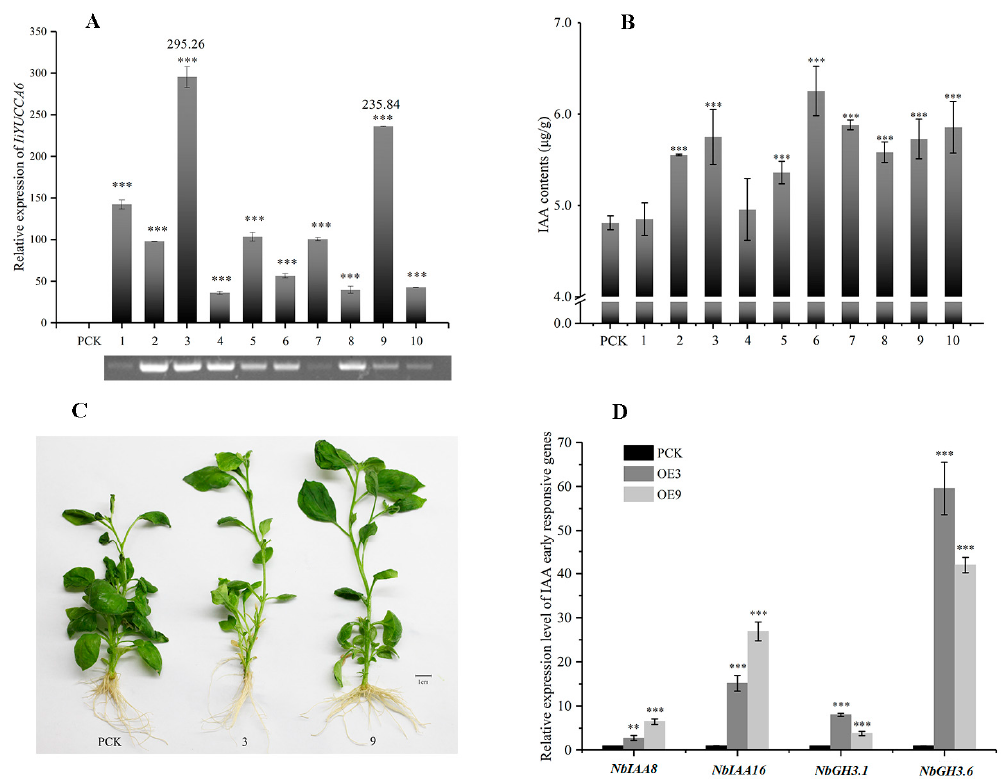
Figure 7. Identification and determination of the over-expressed IiYUCCA6-1 in N. benthamiana (OE1–OE10). ( A ) DNA and RNA detections of transgenic N. benthamiana ; ( B ) IAA content determinations in N. benthamiana ; ( C ) the morphologic changes of transgenic N. benthamiana ; ( D ) the